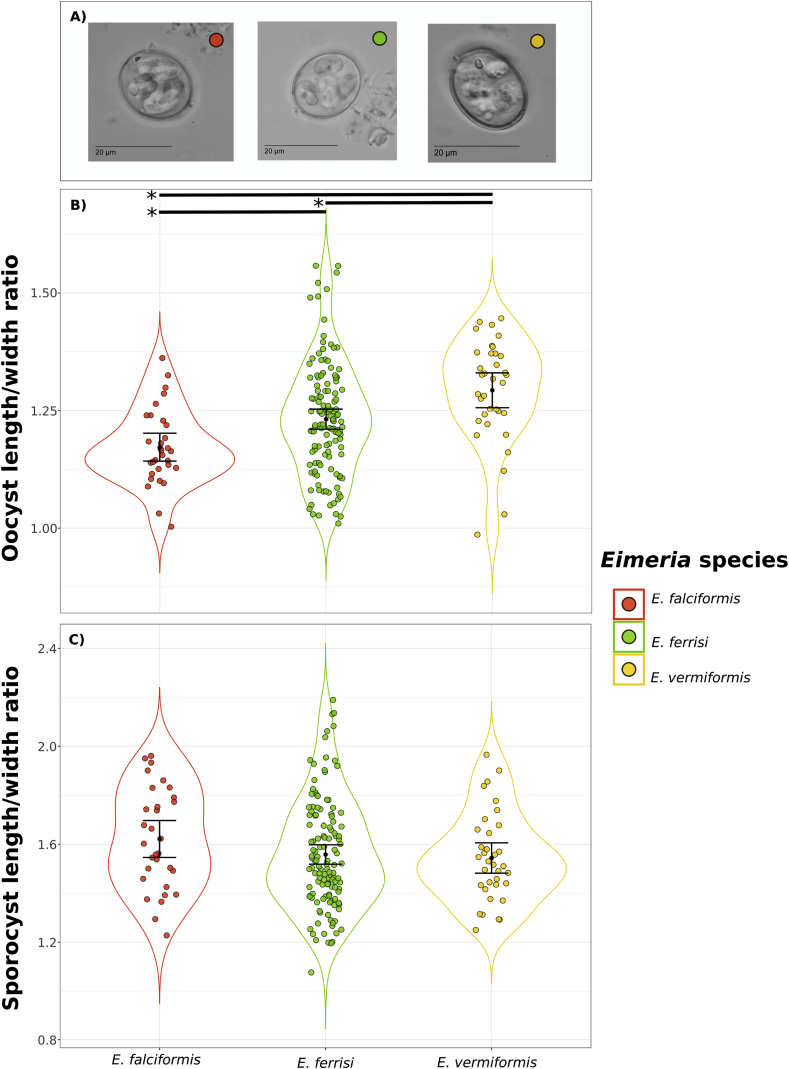
Morphological and morphometrical characteristics of Eimeria oocyst isolated from Mus musculus. a) Photomicrographs at 1000x amplification of Eimeria oocyst from the three species isolated from Mus musculus (red = E. falciformis; green = E. ferrisi and yellow = E. vermiformis). Length/Width ratio from b) oocyst and c) sporocysts corresponding to each species (E. falciformis n = 31; E. ferrisi n = 127 and E. vermiformis n = 35). Mean±95% Confidence Interval is plotted. * Represent significant difference (Tukey HSD, p < 0.05). (For interpretation of the references to color in this figure legend, the reader is referred to the Web version of this article.)